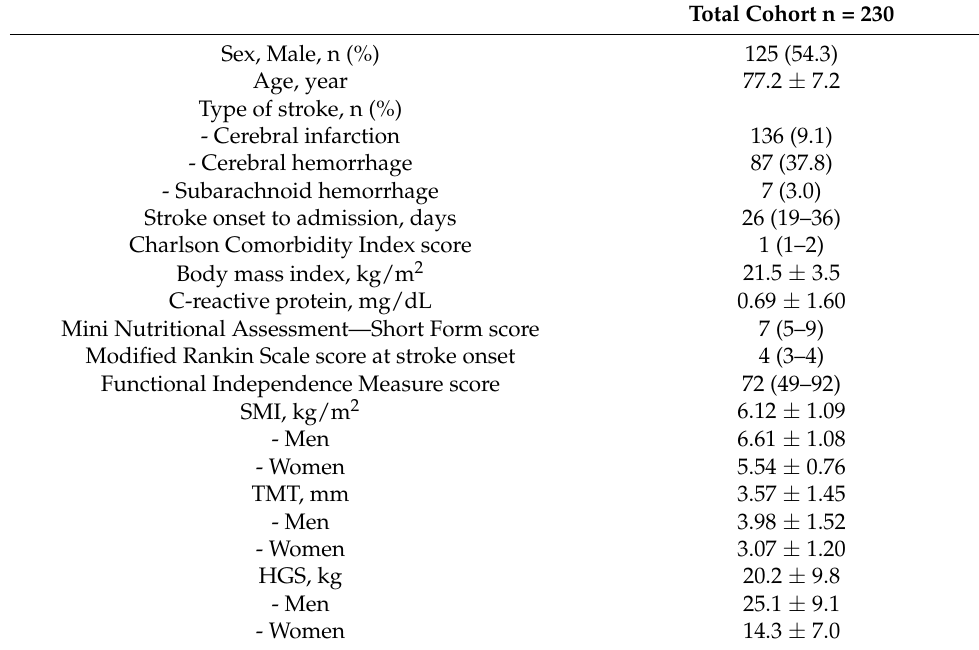
Table 1. Characteristics of the calculation cohort.